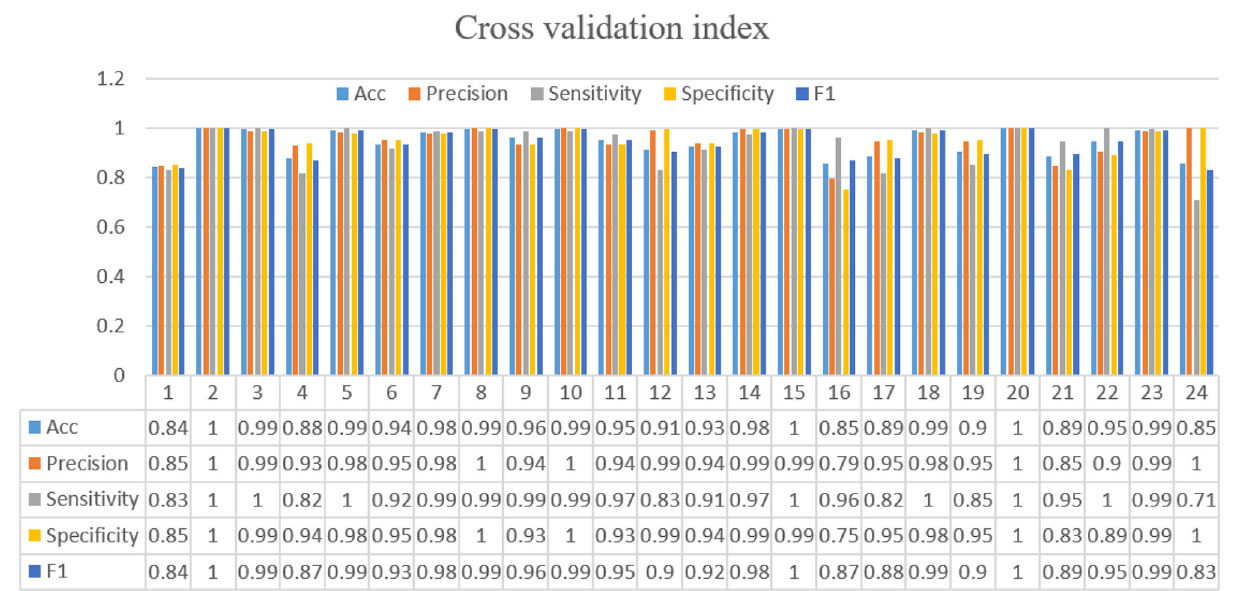
six SENet modules are removed from the model and the comparison before and after the results are shown in Table 4